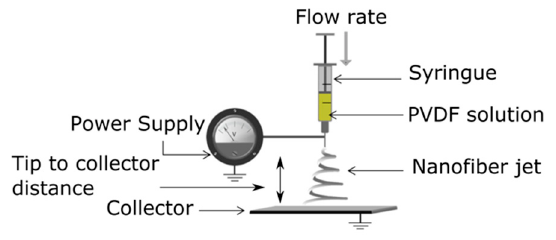
Figure 2. Schematic diagram of an electrospinning setup. A syringe is filled with a polymer solution, a syringe pump is set at a certain feed rate, and a proper voltage is applied between the needle and the collector. The process parameters are adjusted to ensure the formation of a Taylor cone at the tip of the needle. The fine jet extrudes from the Taylor cone, when the electrostatic forces are higher than the surface tension and the viscous forces. The solvent evaporation during the flying pro- cess allows the formation of solid nanofibers recovered on the collector surface. To overcome certain drawbacks, and in particular the low productivity of PVDF elec- trospinning, a great deal of attention has been paid, in recent years, to the modification of the process and device, namely needleless techniques. In one technique proposed by Fang et al. [69] (Figure 3A), a rotary aluminum disc is partially immersed in a PVDF solution, and the solution is connected to a high-positive-voltage DC power supply. A grounded drum collector is placed at a precise distance from the disc. This device allows them to increase the productivity up to 16.9 g/h, compared to that of a needle system of 0.16 g/h, even if the piezoelectric performance of PVDF nanofibers is not significantly increased. Hernández-Navarro et al. [70] used a bubble-electrospinning technique to prepare PVDF nanofibers, which not only significantly increases the piezoelectric properties of PVDF nanofibers, but also greatly improves productivity. In the bubble-electrospinning, a grounded aluminum plate collector is set above the PVDF solution surface. Feeding gas enters the solution and promotes the solution to form a Taylor cone (Figure 3B). In this experiment, by adjusting the applied voltage, the fraction of the β phase is almost 100%. Figure 3. ( A ) Schematic diagram of needleless electrospinning [69] . ( B ) Bubble-electrospinning [71] . Regardless of the traditional solution electrospinning techniques or the novel electro- spinning processes described above, parameters that influence the characteristics and properties of nanofibers produced can be divided in three categories: (i) the polymer so- lution characteristics, (ii) the electrospinning process parameters, and (iii) the ambient pa- rameters. Concerning the polymer solution properties, there are three main influential factors: surface tension, conductivity, and viscosity. The surface tension and conductivity are affected by the solvent, while the viscosity mainly depends on the molecular weight and the concentration of PVDF. Therefore, choosing an appropriate solvent and a proper concentration of PVDF to prepare the solution is crucial in the electrospinning technique.